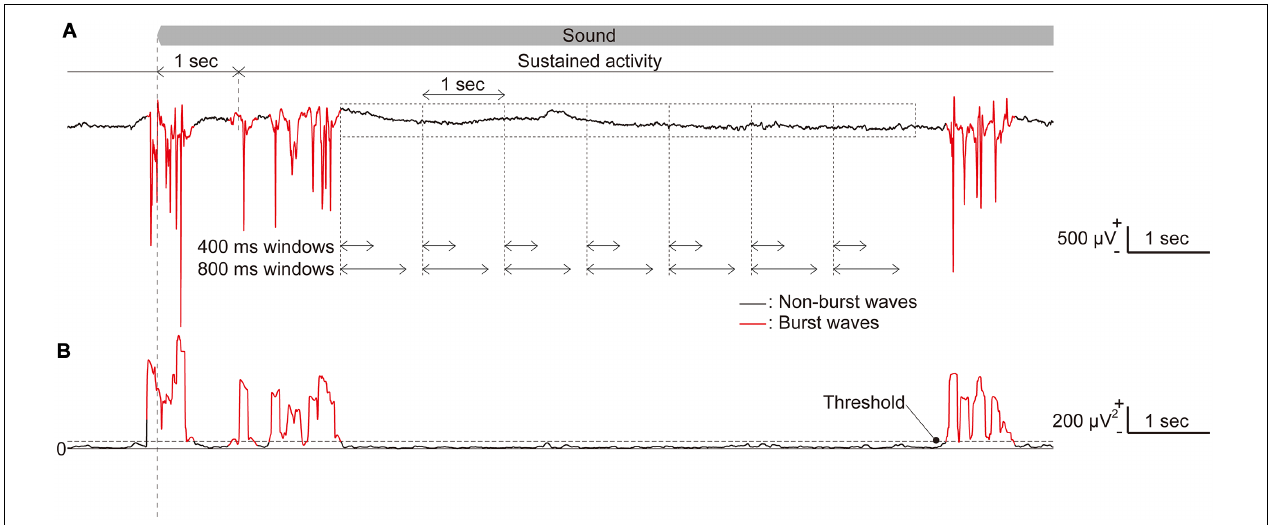
FIGURE 3 | Long-lasting sustained activities. (A) Representative raw traces of long-lasting, sustained LFPs in response to a pure tone with a frequency of 50 kHz. (B) The standard deviation (SD) of a 100-ms LFP, where burst activities were included. Time periods, during which the SD exceeds a threshold in more than 24 recording sites and with durations of 150 ms or longer, were classified as burst LFPs (red line) while others were classified as non-burst LFPs (black line). The time window length used in the analyses was chosen from five tested durations.